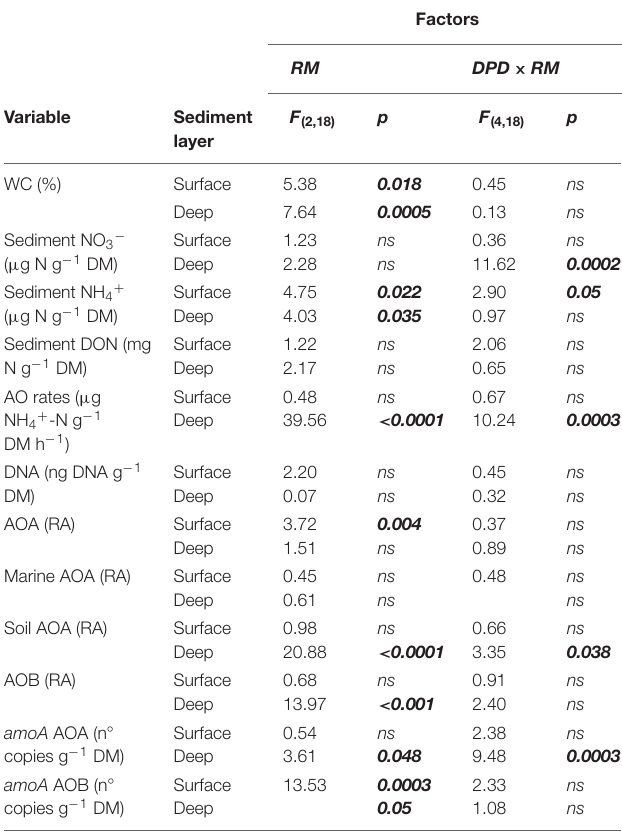
Models included the factors: dry period duration (DPD = 3, 6, and 9 weeks), rainfall magnitude (RM: 0, 4, and 21 mm) and interaction of both factors.